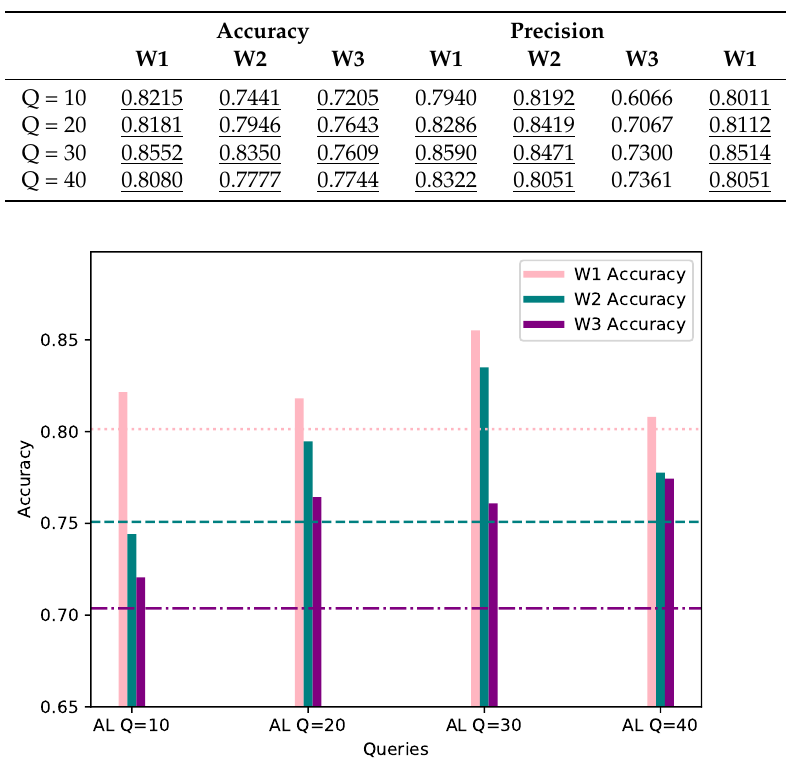
Figure 6. Accuracy of W1, W2 and W3’s models personalized with 50% AL dataset bias ( Y -axis) per Query ( X -axis), evaluated using their corresponding evaluation datasets. The FL accuracy for each worker is represented by the horizontal line of the worker’s respective